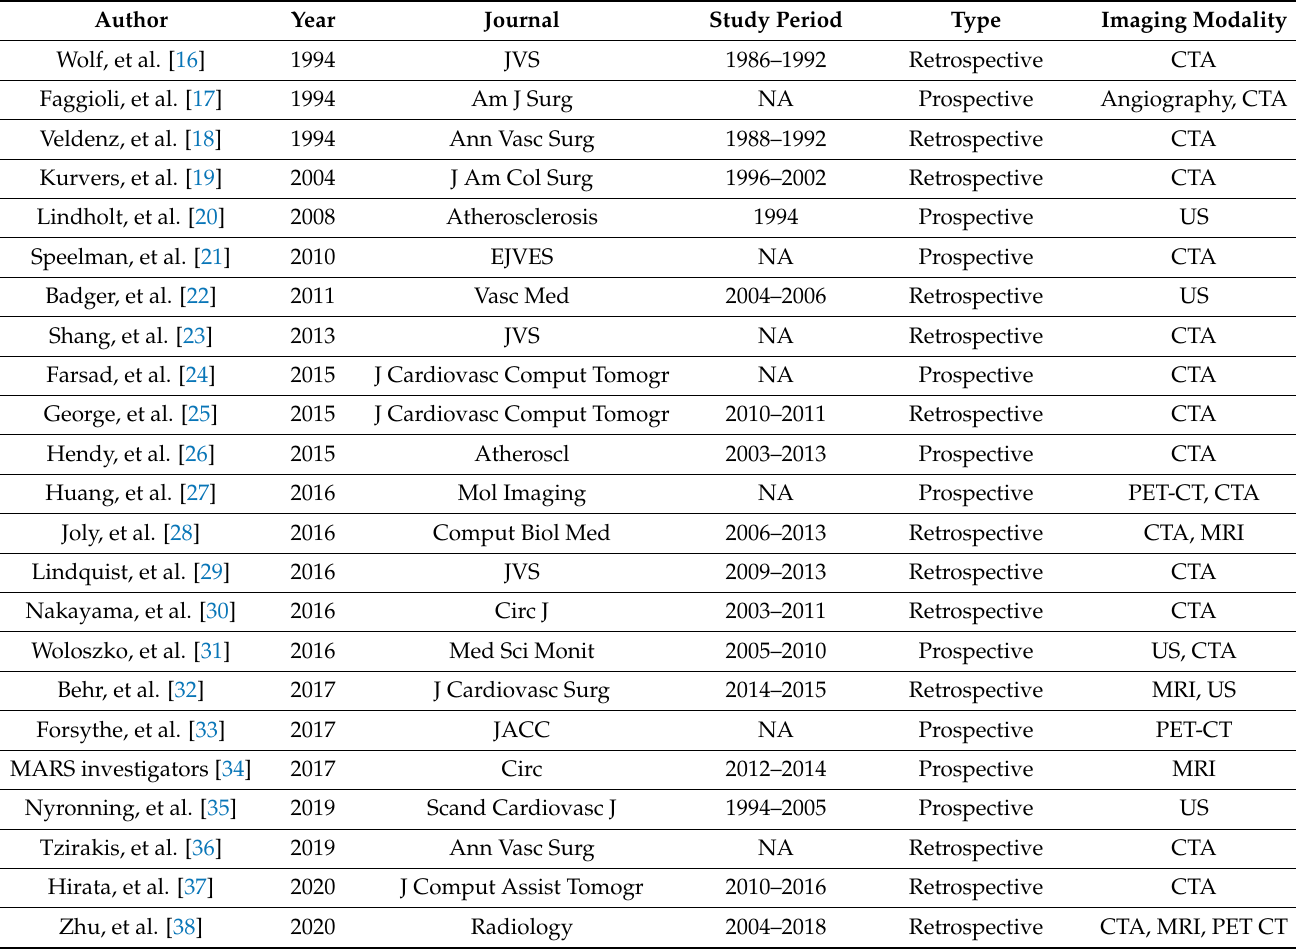
Table 2. Retrospective and 10 prospective. All patients underwent imaging with different modalities; the initial evaluation was followed by one or more studies to assess AAA (abdominal aortic aneurysm) expansion. Different modalities were applied including CTA, MRI, PET and US or a combination of them.